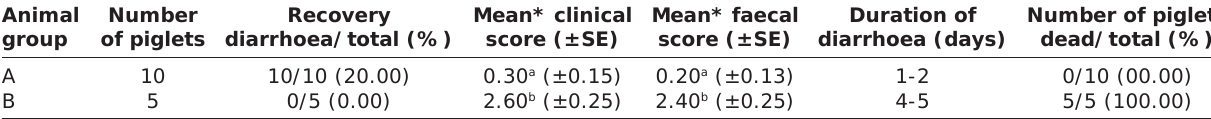
Table-3: Protection study in diarrhoeic piglets fed with egg yolk from immunized hens. Animal Number group of